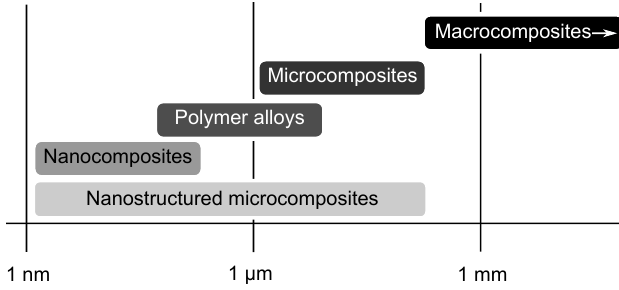
Figure 3. Classifications of composite materials depending on the filler size (redrawn and adapted from: [16,27]).